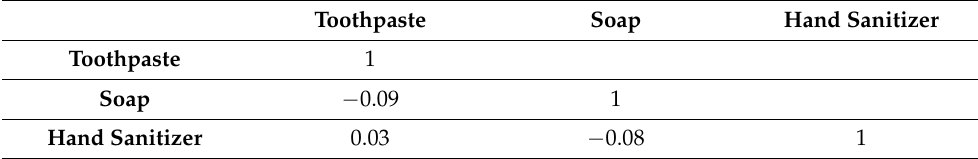
Table 10. Pairwise correlation matrix for the net price of the first search result. Soap is Method body